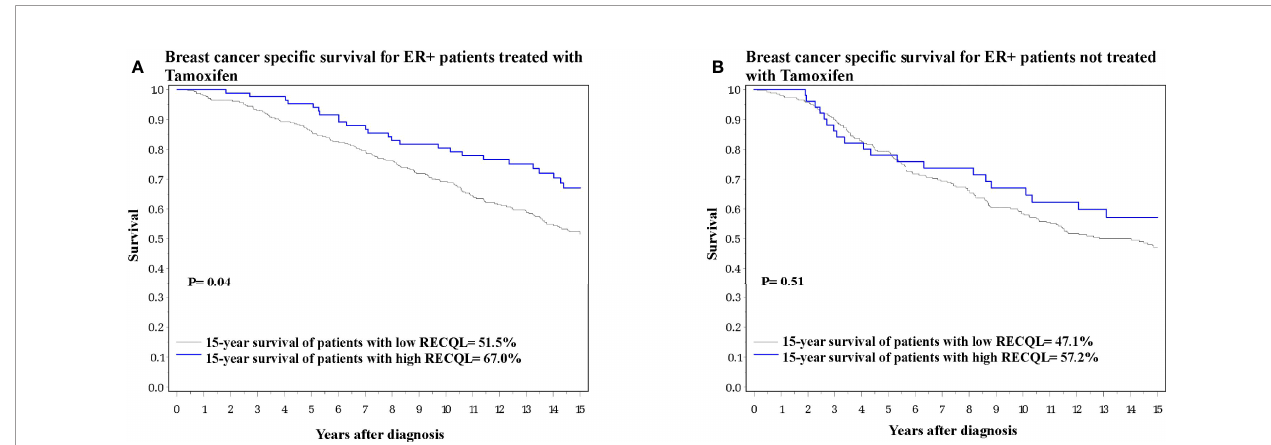
FIGURE 2 | Breast cancer speci fi c survival among ER-positive patients based on RECQL protein expression. (A) Breast cancer speci fi c survival among ER-positive patients who received Tamoxifen based on RECQL protein expression. (B) Breast cancer speci fi c survival among ER-positive patients who did not receive Tamoxifen based on RECQL protein expression.